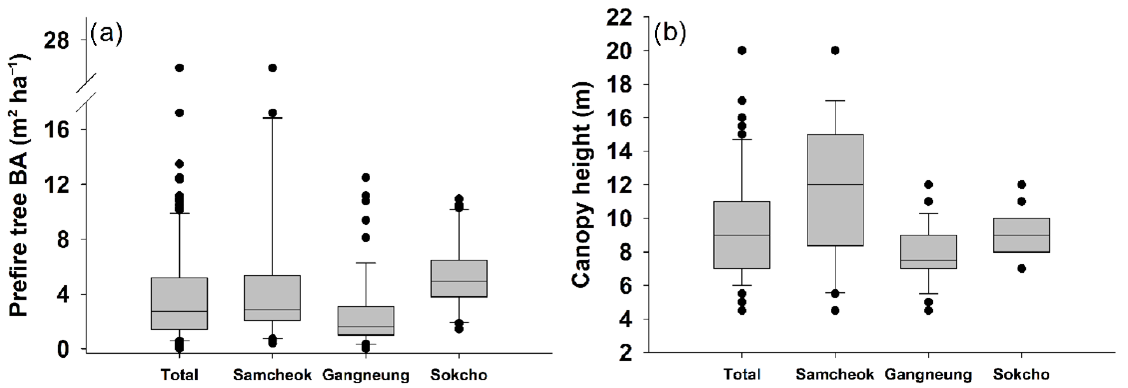
Figure 5. Two variables of prefire forest factor: ( a ) basal area of the trees with resprouting ability, ( b ) canopy height. Fifty, 66, and 36 plots were investigated in Samcheok, Gangneung, and Sokcho, respectively, resulting in a total of 152.